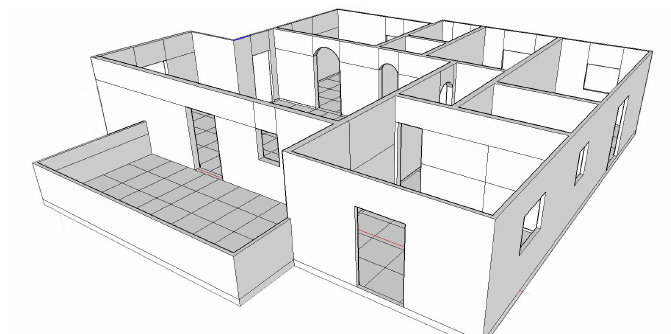
Figure 3. Example of 3D extrusion created with the automatic 3D environment creation.